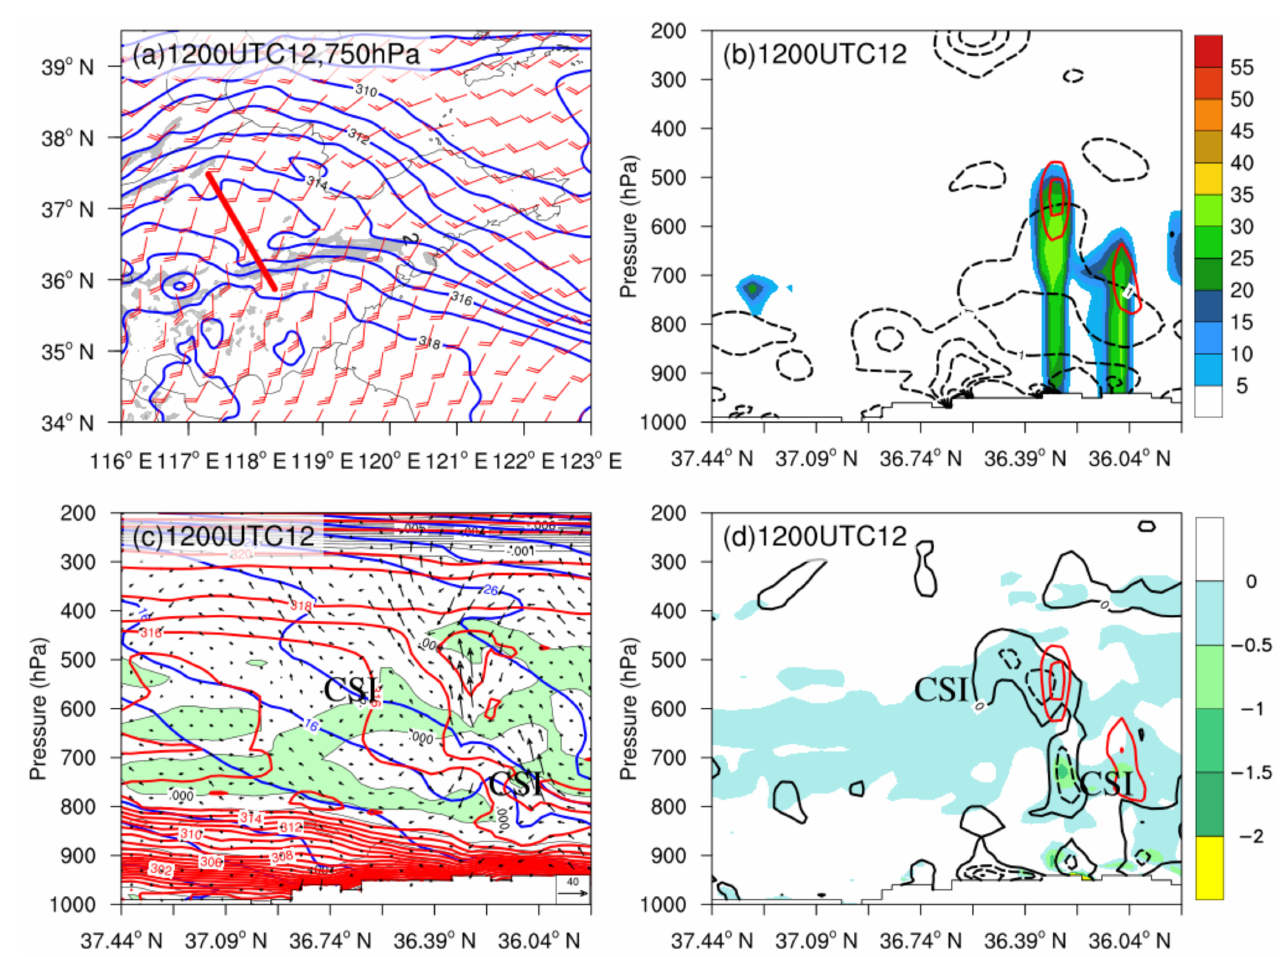
Figure 10. ( a ) The 4 km-grid simulated 750 hPa frontogenesis function (shaded; unit: K (100 km · h) − 1 ), saturation equivalent potential temperature (blue lines; contoured every 1 K), and wind barbs (unit: m · s − 1 ) valid at 1200 UTC on 12 February 2016. ( b ) Cross section of the 4 km grid simulated radar reflectivity (shaded; unit: dBZ), frontogenesis function (black dashed lines; unit: K · (100 km · h) − 1 ), and ascent (red lines; contoured every 0.2 m · s − 1 , and starting from 0.2 m · s − 1 ) valid at 1200 UTC on 12 February 2016. ( c ) Cross section as in ( b ) but with saturation equivalent potential temperature (red > 0 ) (green shaded), and vertical circulation. lines; unit: K), M (blue lines; unit: m · s − 1 ), area of ( ∂θ es ∂ p ( d ) Cross section as in ( b ) but with EPV (shaded where negative according to scale), negative absolute vorticity (black dashed lines; contoured every 20 × 10 − 5 s − 1 s − 1 ,) and microphysical heating rate (red lines, contoured every 8 K · s − 1 , and starting from 8 K · s − 1 ). CSI in ( c , d ) denote regions of